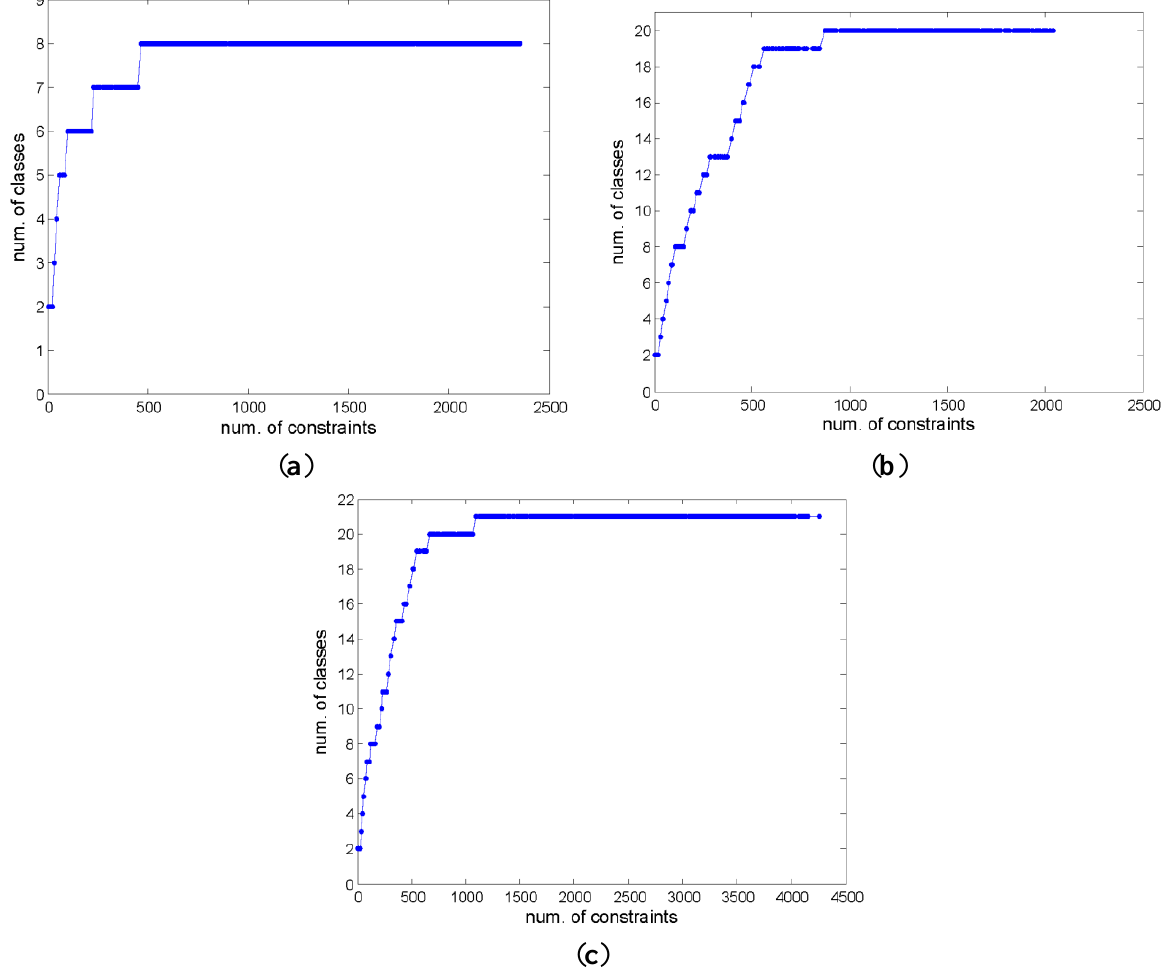
Figure 13. Change in the number of classes changes with an increasing number of constraints in AASC: ( a ) Beijing; ( b ) WHU-RS; and ( c )